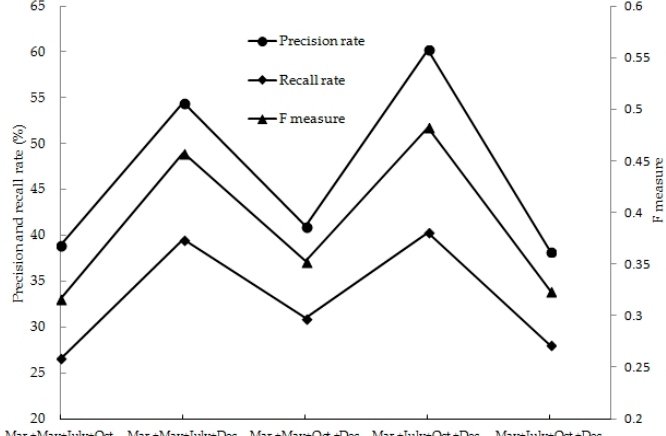
Figure 11. Precision rate, recall rate, and F measure values for the QVP detection from the five combined four-season datasets.